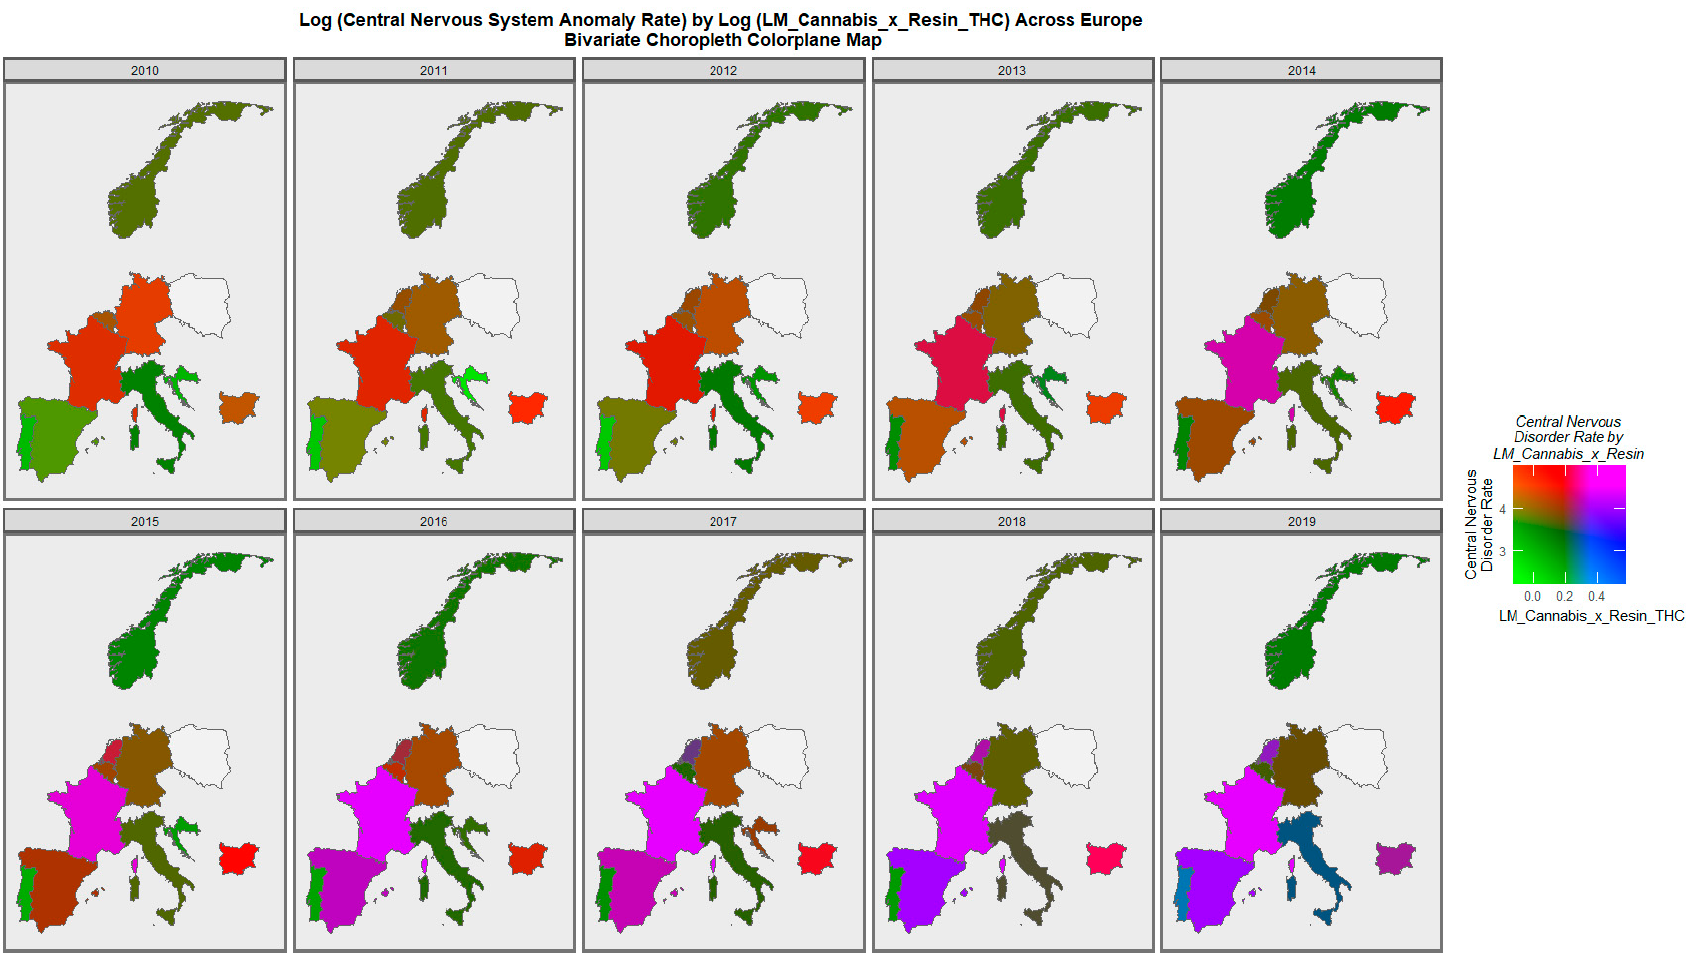
Figure 6. Bivariate colorplaner sequential map-graphs of log (central nervous system anomaly rates) by log of last month cannabis use: cannabis resin THC concentration across surveyed European nations over time, 2010–2019.